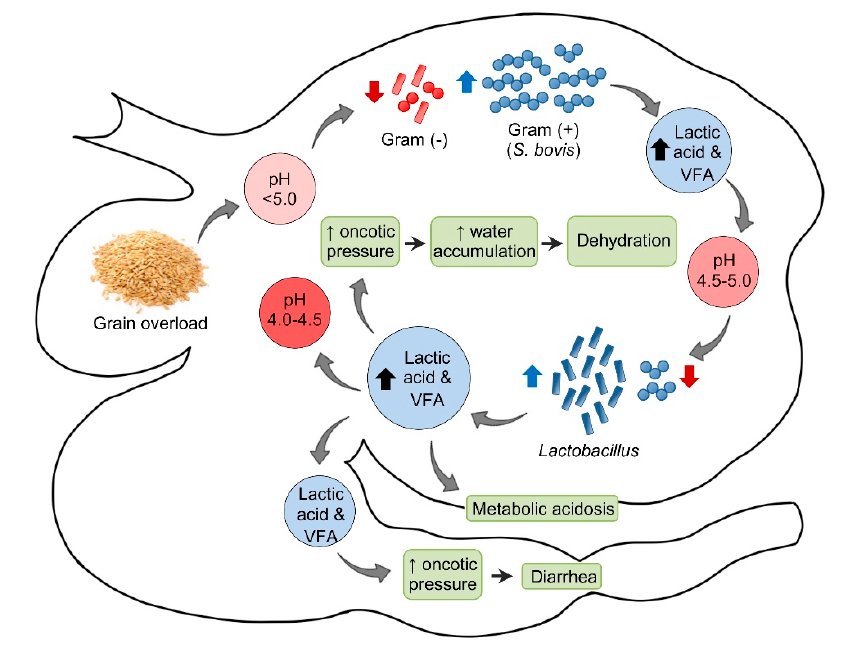
Figure 1. Pathogenesis of ruminal acidosis. VFA = Volatile fatty acids.